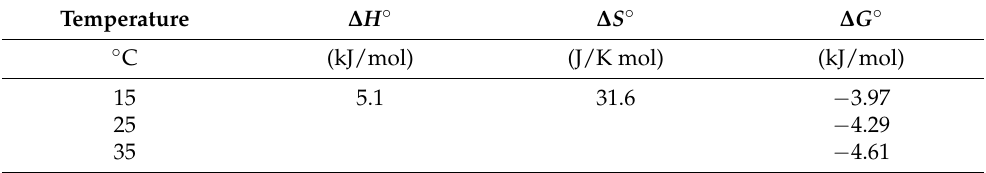
Table 7. The estimated thermodynamic parameters for the adsorption of As(III) on Al-FWB.